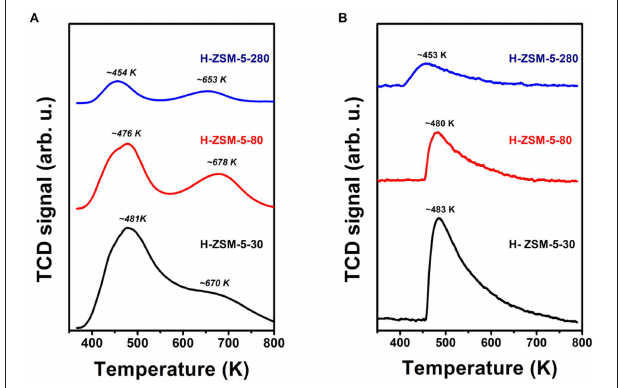
summarized in Table 1 . The BET surface area of H-ZSM-5